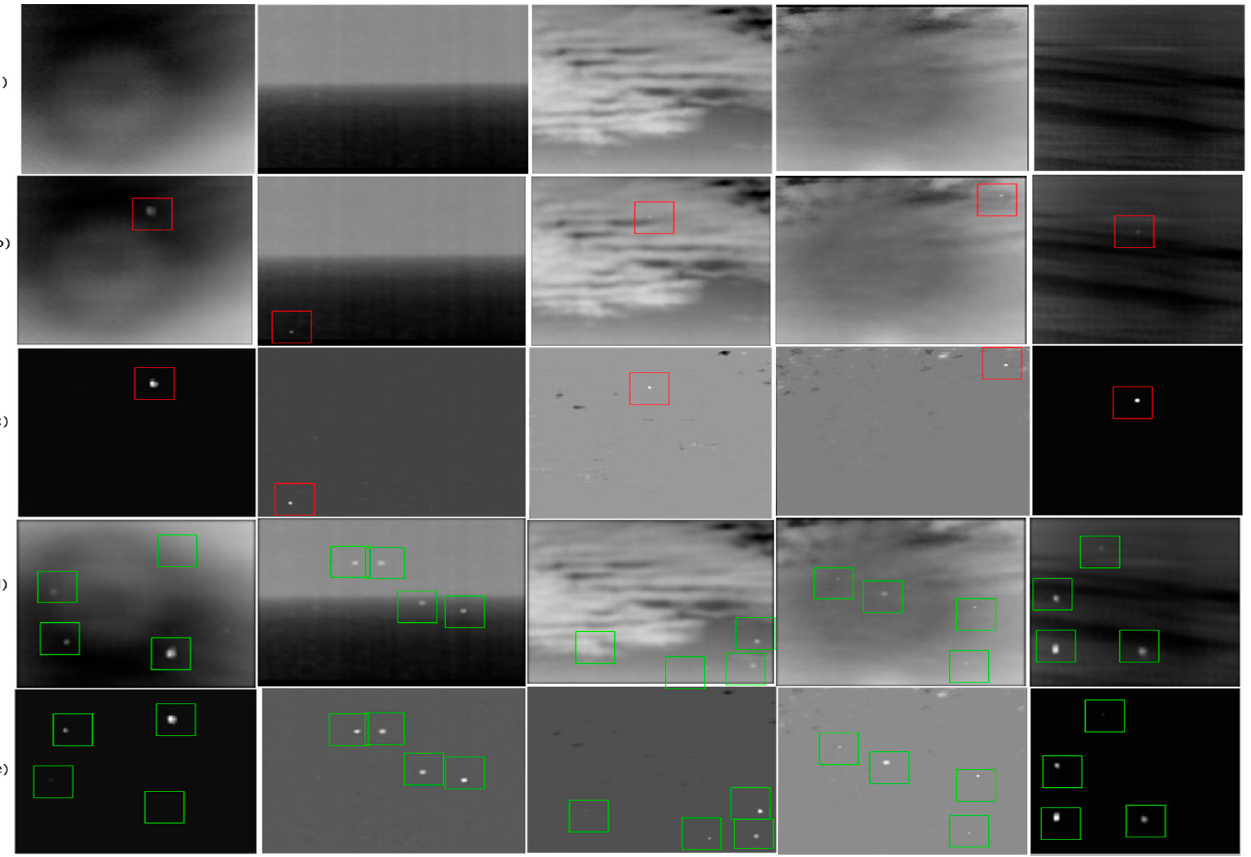
Figure 12. Experimental results for the synthetic image sequences ( a ) Background—synthetic image sequences. ( b ) Images with one target and ( c ) background suppression of Figure 9b. ( d ) Images with four different small targets. ( e ) Background suppression of Figure 9d.